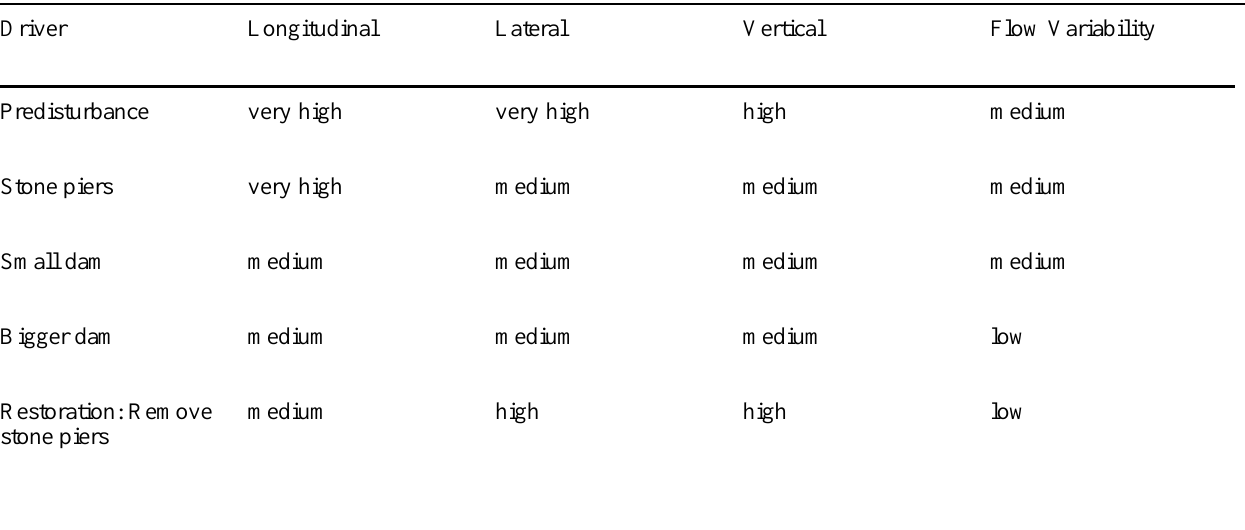
Table 1. Pite River degradation and restoration: sequence of changes with connectivity expressed on a relative